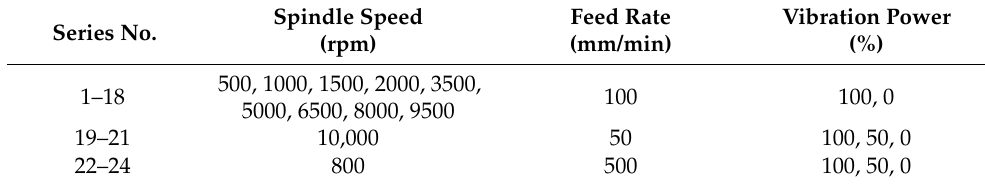
Table 2. The details of the experiment design.